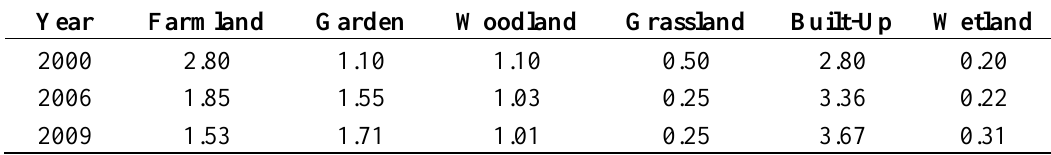
Table 8. Demand distribution coefficients for different land-use